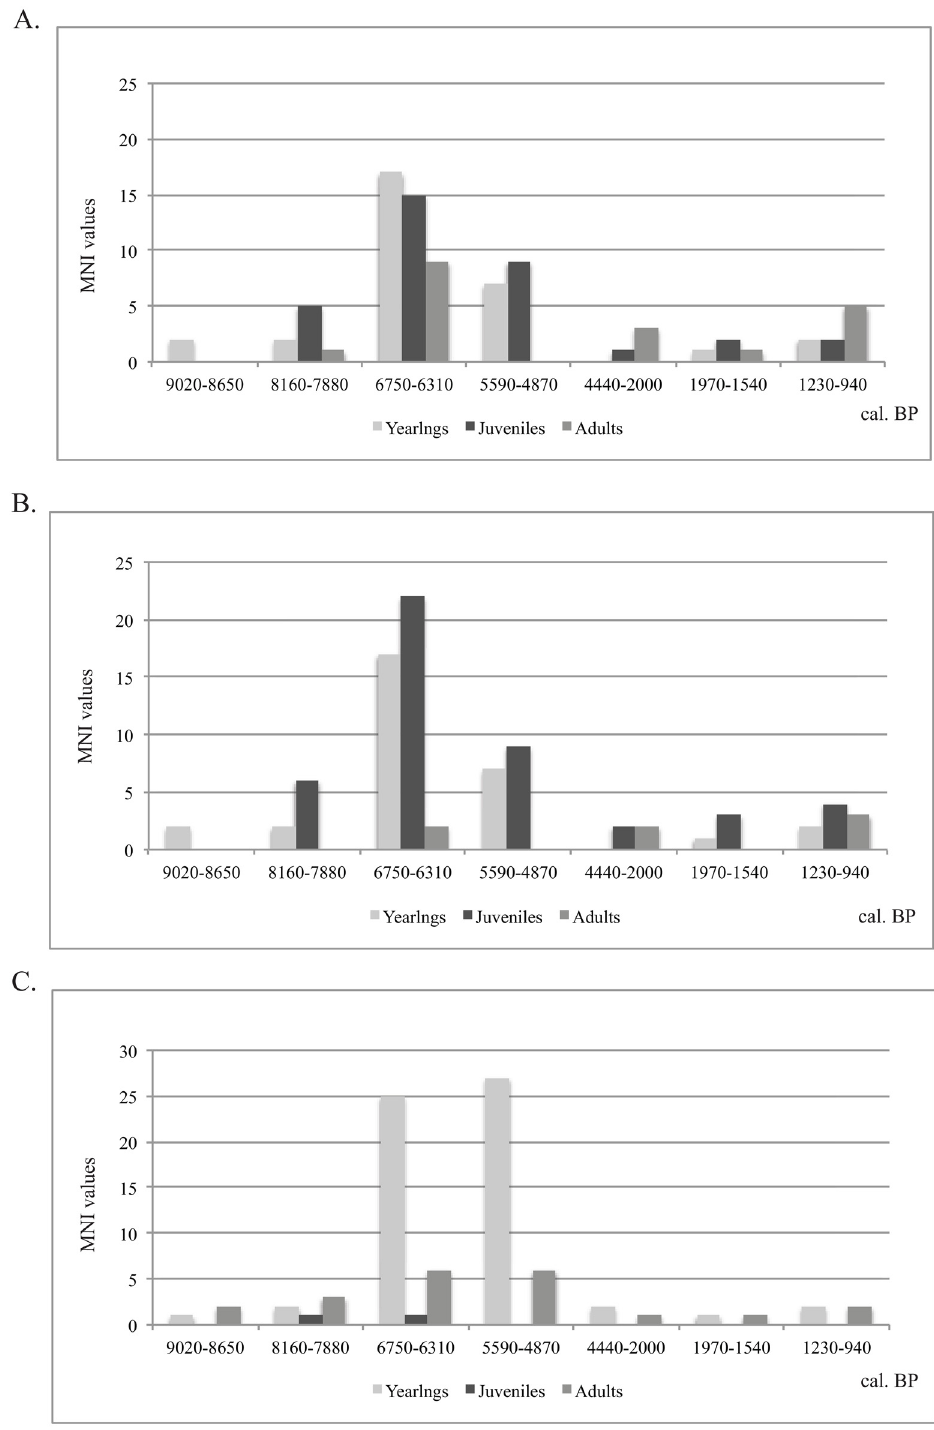
Fig 5. Seal age groups at Sagan-Zaba II. A: age groups based on canine incremental structures using female age of maturity; B: age groups based on canine incremental structures using male age of maturity; C: age groups based on epiphyseal fusion of long